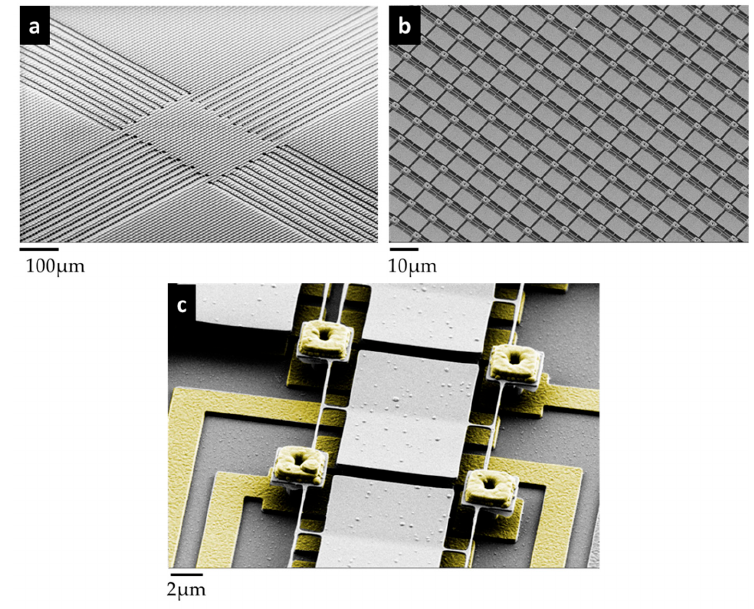
Figure 3. Scanning electron microscopy (SEM) pictures of an array of electromechanical pixels fabricated with a low ‐ temperature process: ( a ) Large field view of an array; only the central 96 × 96 array is connected to electrical pads; pixels above the connection wires have been removed to avoid any cross ‐ talk; ( b ) Zoom ‐ in on the center of the array; ( c ) SEM picture of a typical H ‐ shape pixel; Nanorod length = 1.5 µ m, width = 250 nm and thickness = 180 nm (insulation arm length = 8.6 µ